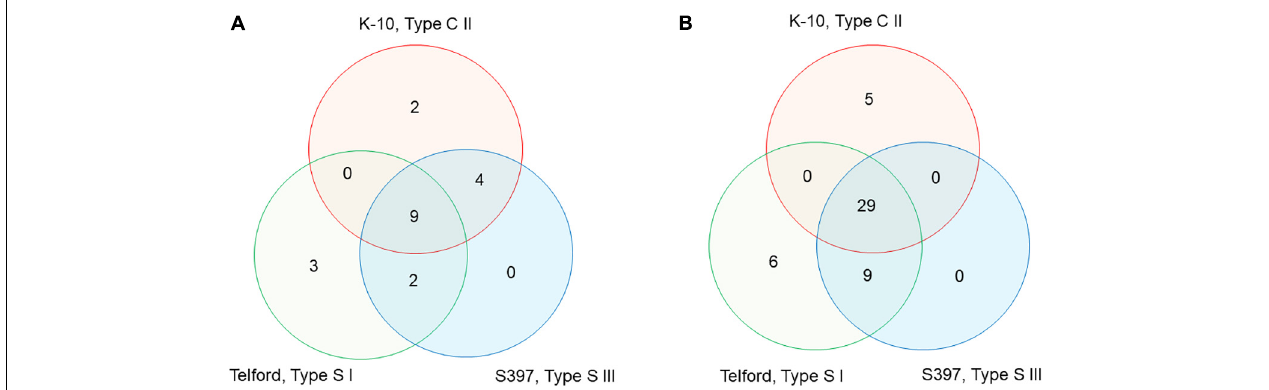
FIGURE 5 | Venn diagram, showing IS 900 orthologous sites and orthologous loci between the three Map genomes. (A) The diagram indicates the number of IS 900 sites unique or orthologous between 2 and 3 genomes. (B) The diagram indicates the number of orthologous or unique loci upstream and downstream of the IS 900 between genomes. Refer to Supplementary Table 2 for additional